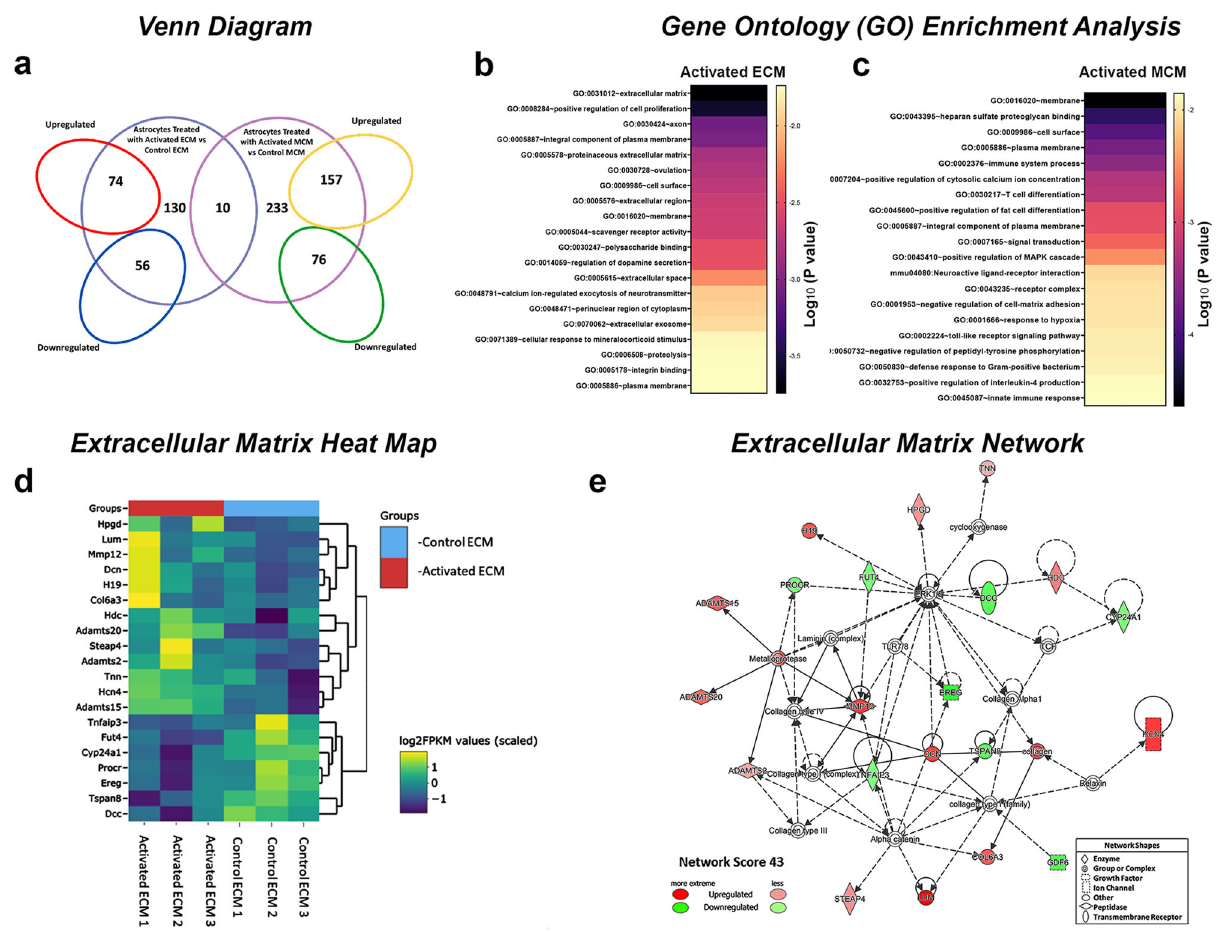
Fig. 4 Endothelial activated astrocytes are enriched in extracellular matrix remodeling genes. a Venn diagram of the RNA-seq analysis showing the intersection of genes enriched in transcriptomes of astrocytes treated with activated MCM and activated ECM. b, c DAVID bioinformatics gene ontology enrichment analysis of differentially expressed genes upregulated in astrocytes treated with activated ECM and activated MCM d RNA-seq generated heatmap of extracellular matrix gene expression (yellow = upregulation, purple = downregulation) and e network analysis of top scored network by ingenuity pathway analysis from astrocytes treated with activated ECM. n = 3. Due to the small sample size and exploratory purpose, statistical signi fi cance is reported by raw p values, and is not corrected by